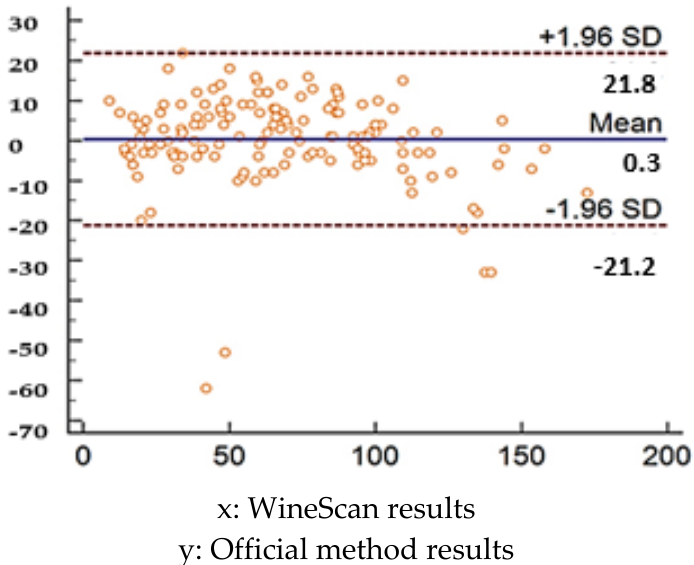
Figure 4. Bland–Altman Test of SO 2 results obtained by the official method and WineScan technology. The dashed line represents the regression confidence. The continuous line represents the interval limits.